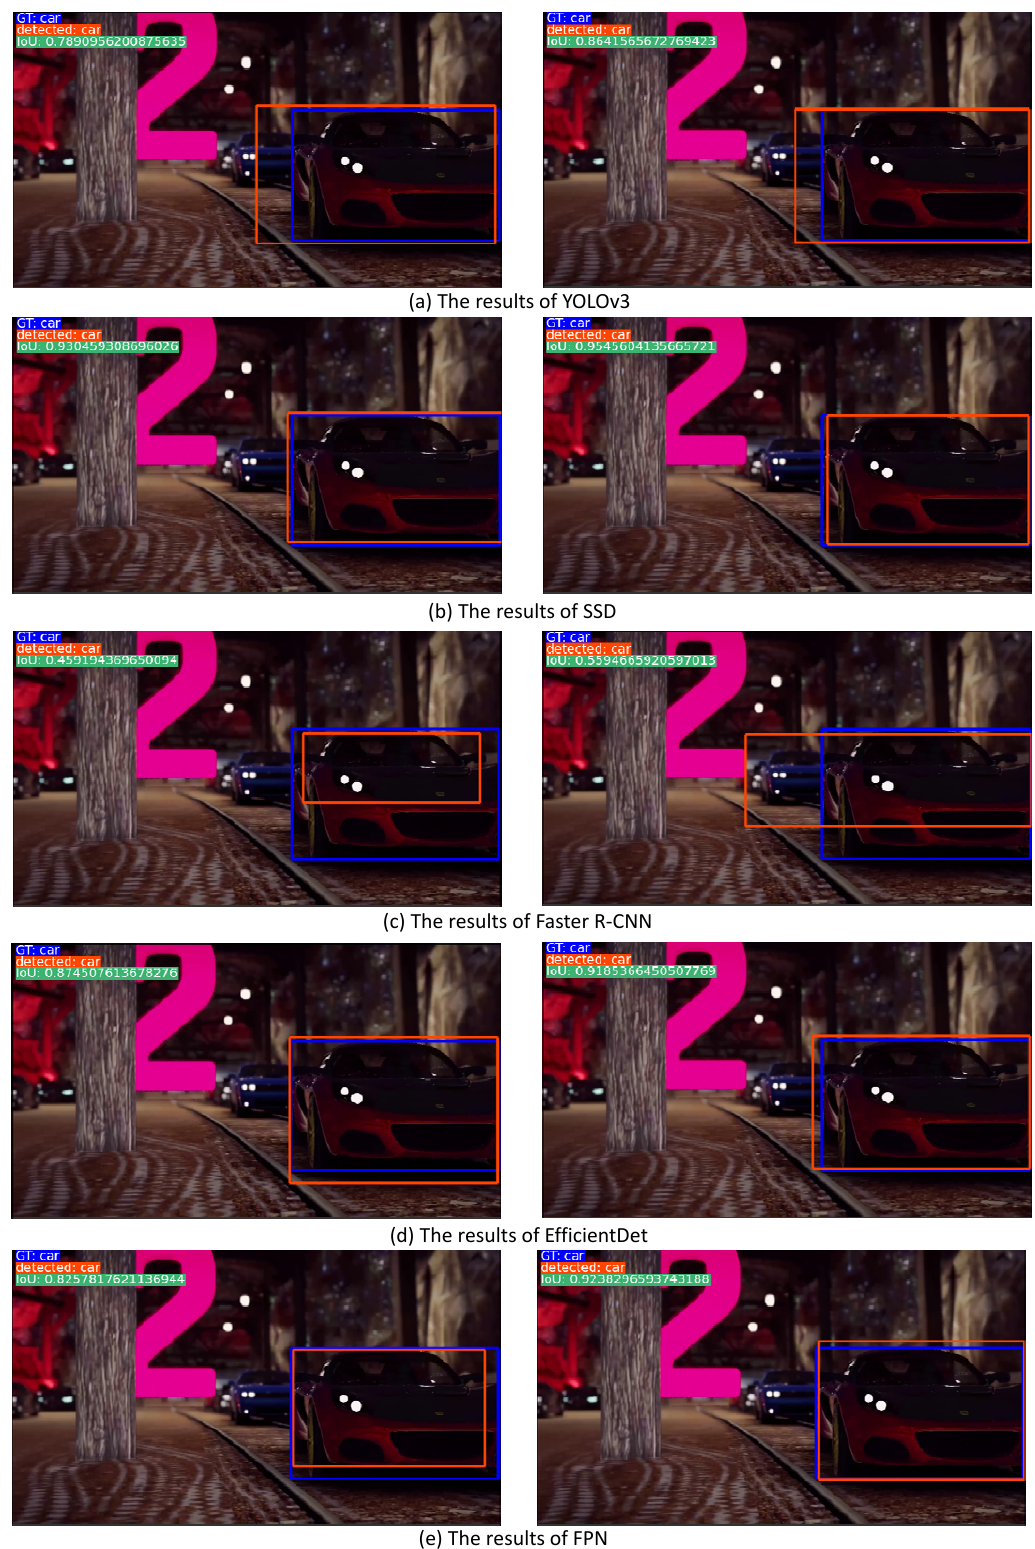
Figure A4. Comparison of the bounding box detection on game Asphalt 8 . The left column is the result from the models trained by PASCAL VOC and the right column is the result from the models trained by PASCAL VOC and game